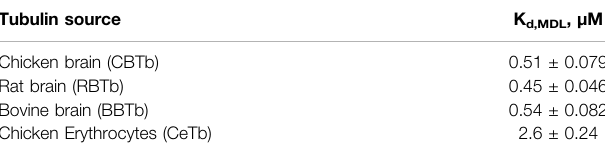
TABLE 2 | Apparent dissociation constants for the Tubulin — MDL interaction measured by dilution